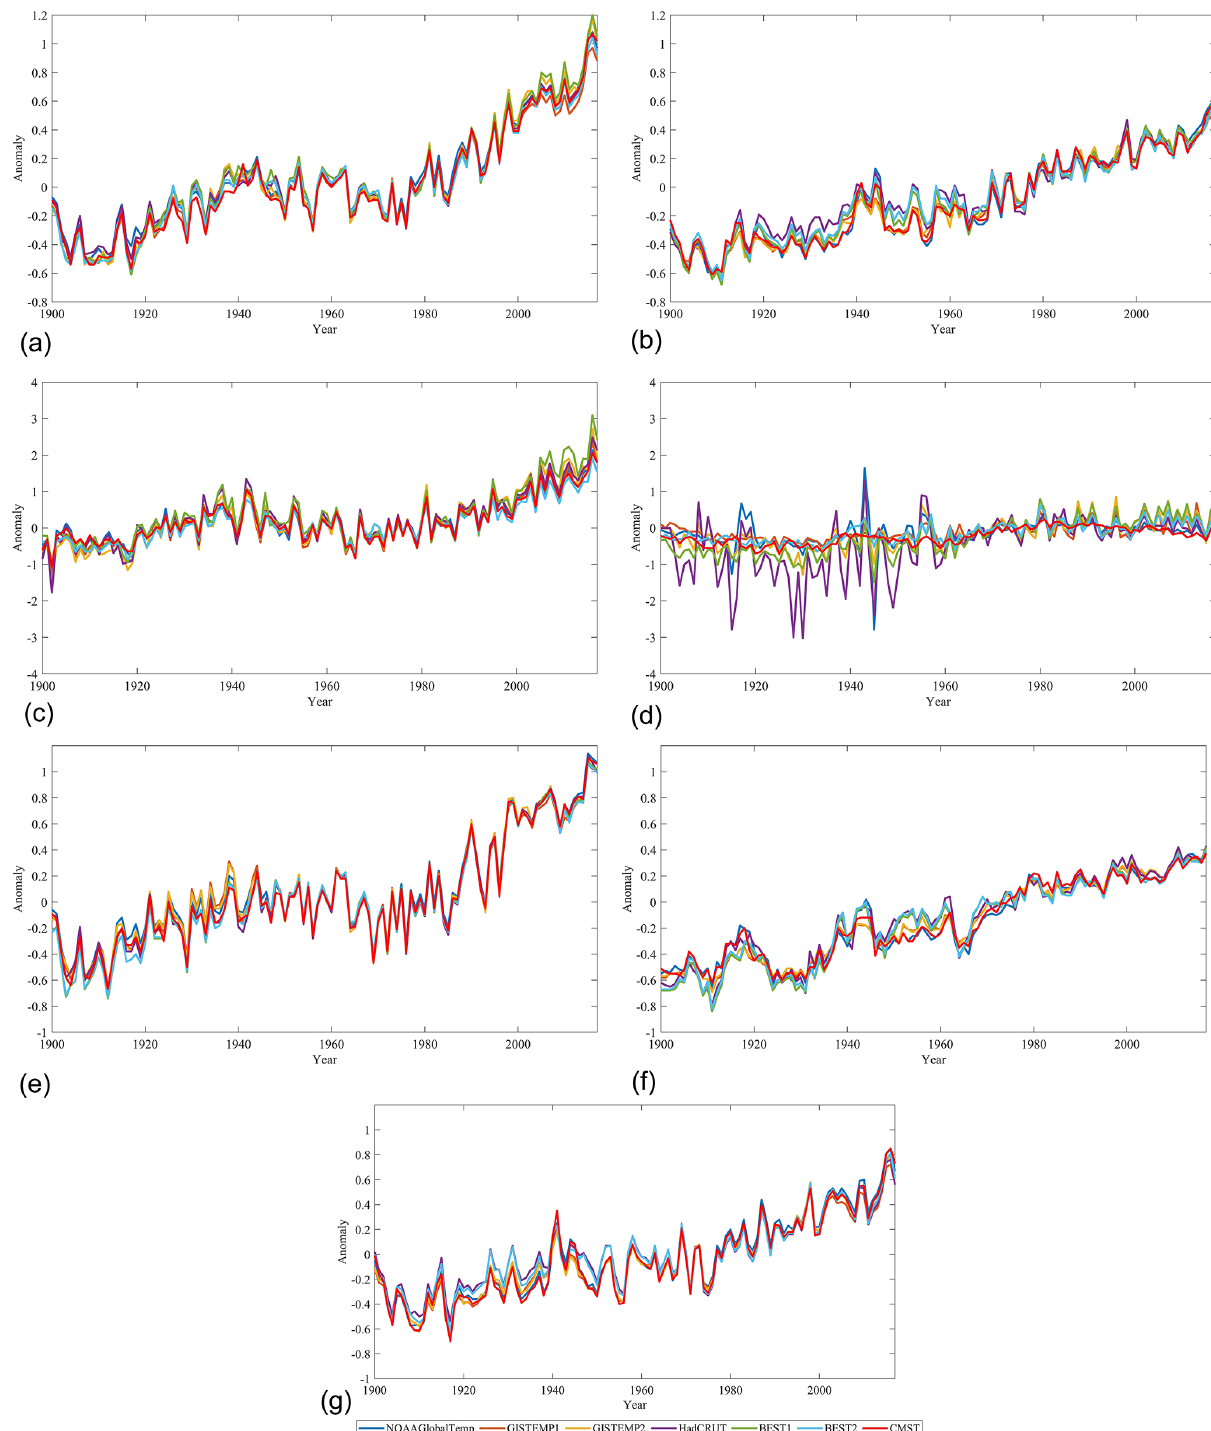
Figure 9. Comparison of regional ST anomalies series during 1900–2017 in (a) NH, (b) SH, (c) 90–60 ◦ N, (d) 60–90 ◦ S, (e) 60–30 ◦ N, (f) 30–60 ◦ S, and (g) 30 ◦ N–30 ◦